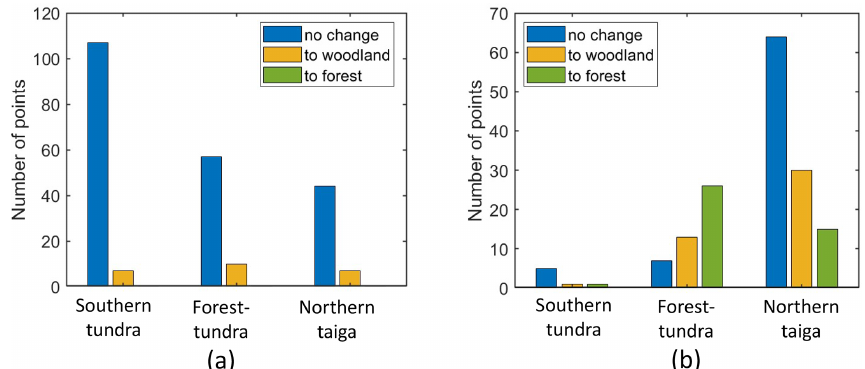
Figure 10. Number of checkpoints corresponding to different classes of vegetation type change for three vegetation zones: (a) non-disturbed territories, (b) fire-affected territories. Change classes: no change means that tundra was both in the old and modern images; to woodland means that tundra turned to woodland, and to forest means that tundra turned to forest. Vegetation zones (southern tundra, forest–tundra and northern taiga) are based on topographic maps (Fig. 9). The time interval is ca. 60 years.